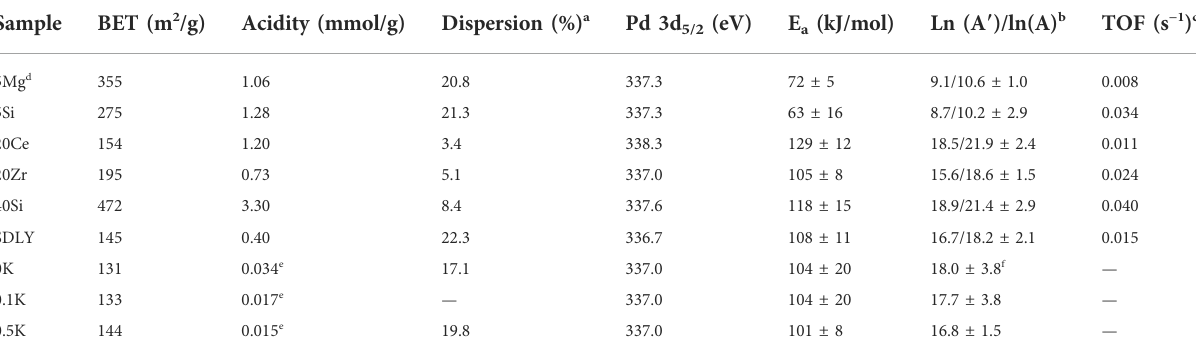
TABLE 1 Characteristics of Pd-loaded